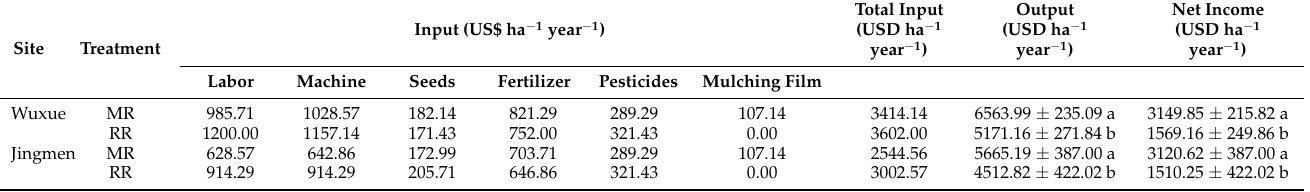
Table 10. Economic input and net income for the MR and RR cropping systems at Wuxue and Jingmen over three